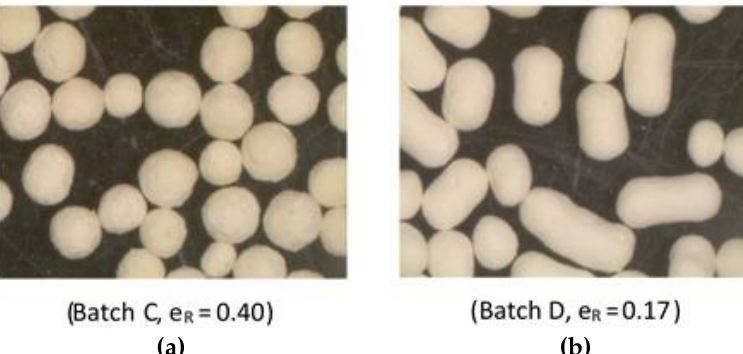
Figure 1. Images of pellet batches C ( a ) and D ( b ) showing different shapes.